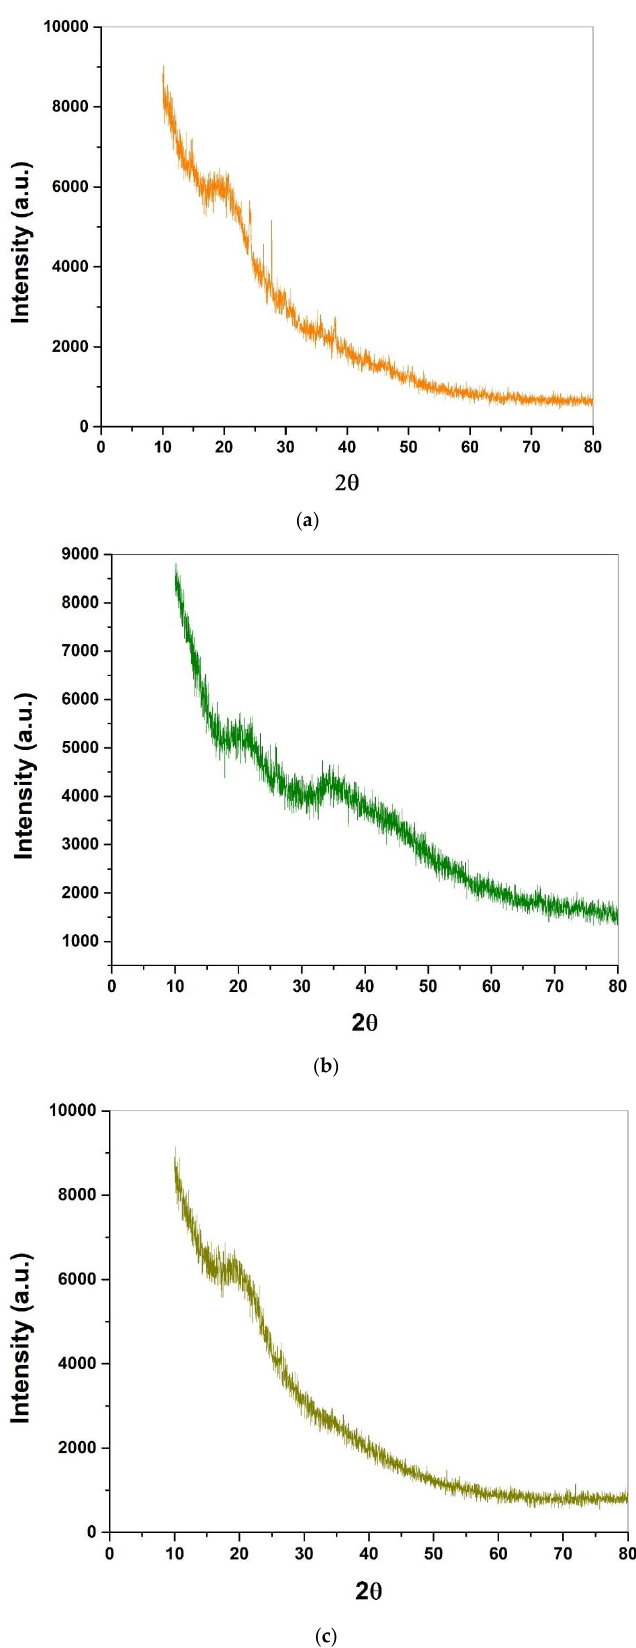
Figure 11. XRD analysis of the bio-composite samples at various ratio of fenugreek ( a ) 5%, ( b ) 10%, and ( c ) 15%.